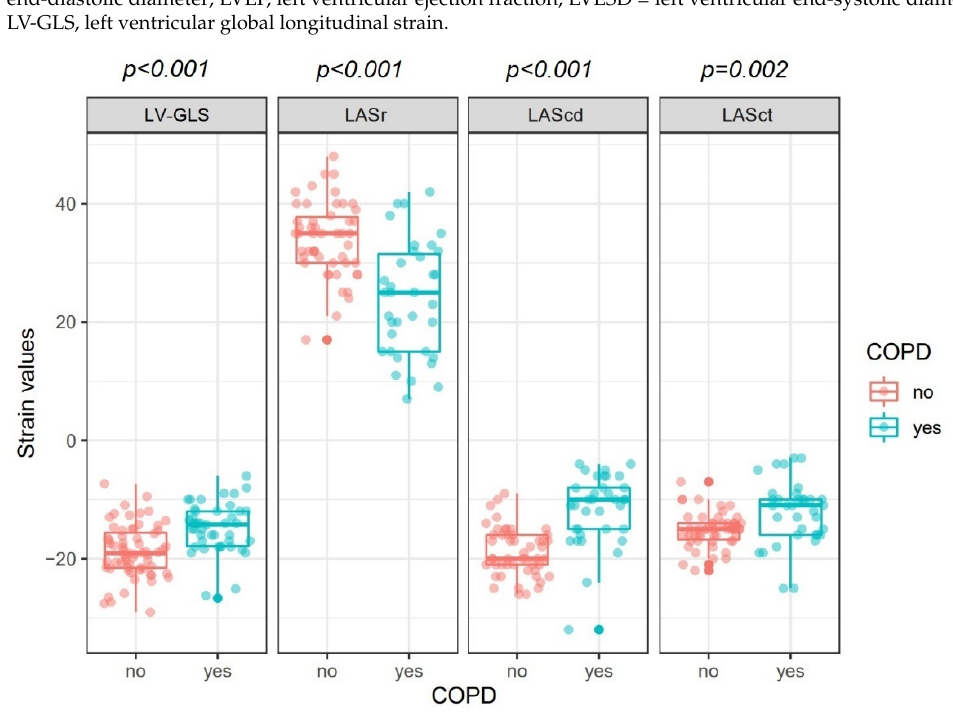
Figure 3. Left ventricular and left atrial strain values among patients with and without COPD. Abbreviations: COPD, chronic obstructive pulmonary disease; LAScd, left atrial strain during conduit phase; LASct, left atrial strain during contraction phase; LASr, left atrial strain during reservoir phase; LV-GLS, left ventricular global longitudinal strain.